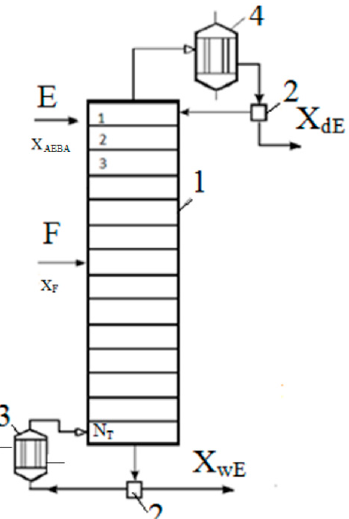
Figure 10. Calculation scheme of the extractive distillation column: 1—distillation column, 2—separator, 3—boiler, 4—reflux condenser.